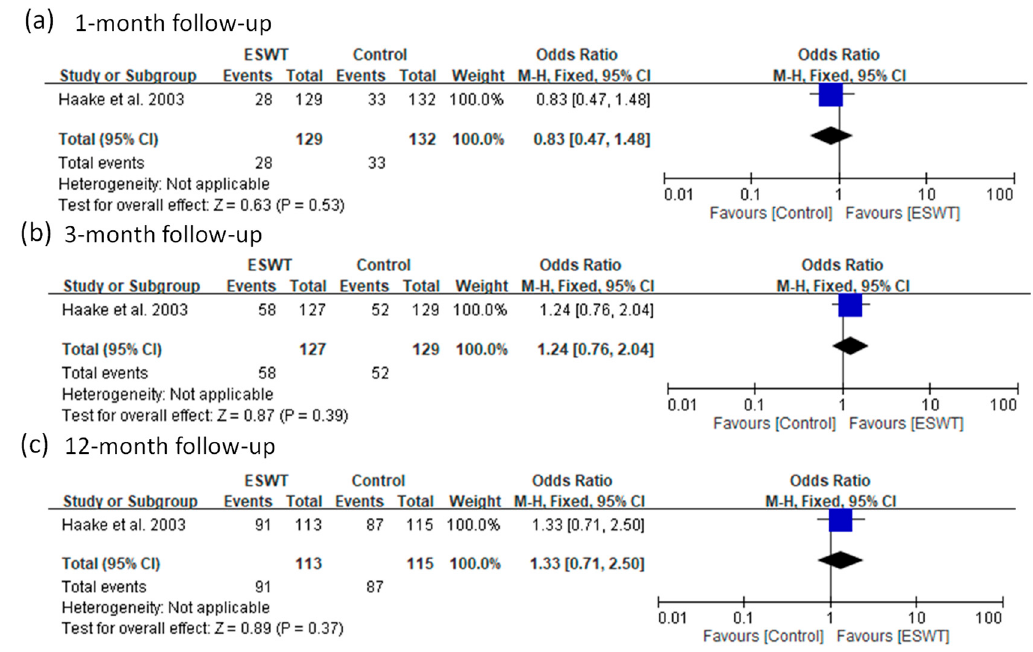
Figure 6. Forest plots of treatment success rates in low-energy ESWT and placebo-controlled groups at 1-month ( a ), 3-month ( b ), and 12-month ( c ) follow-ups. VAS Score